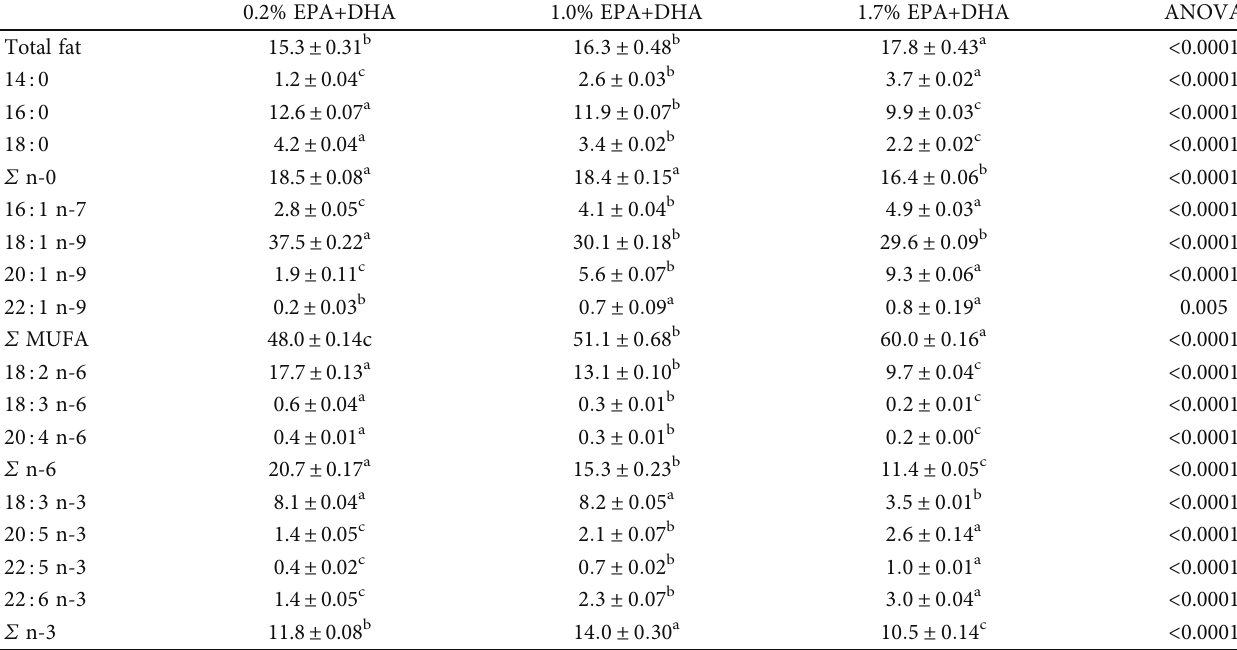
Table 4: Fatty acid composition (% of total) in the muscle at slaughter (3.5 kg) of Atlantic salmon fed the experimental diets for 26 weeks (period 1) and period 2 A and B (13 months). Data are shown as mean ± sem ( n = 24 , being each sample represented by a pool of 2 fi